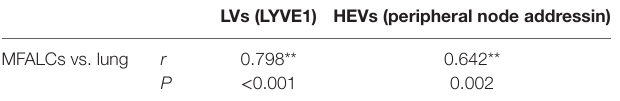
TaBle 3 | Correlations between relative ratios of LVs and high endothelial venules (HEVs) in mediastinal fat-associated lymphoid clusters (MFALCs) and the lungs.